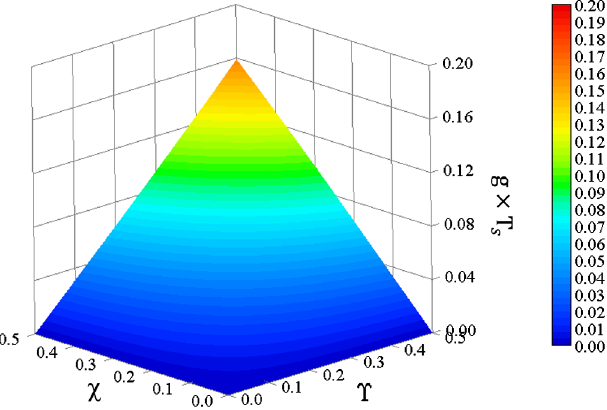
FIG. 9. The growth factor g × T they are less than 0.5.